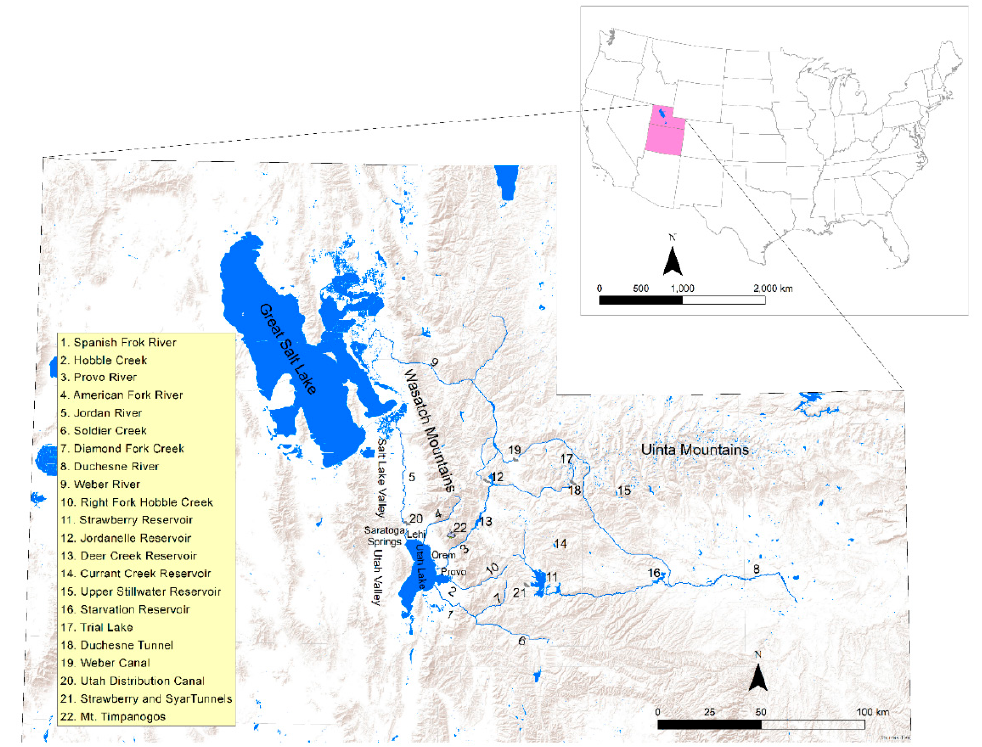
Figure 1. Map showing northern Utah and the geographic locations, landforms, and structures mentioned in the text. mentioned in the